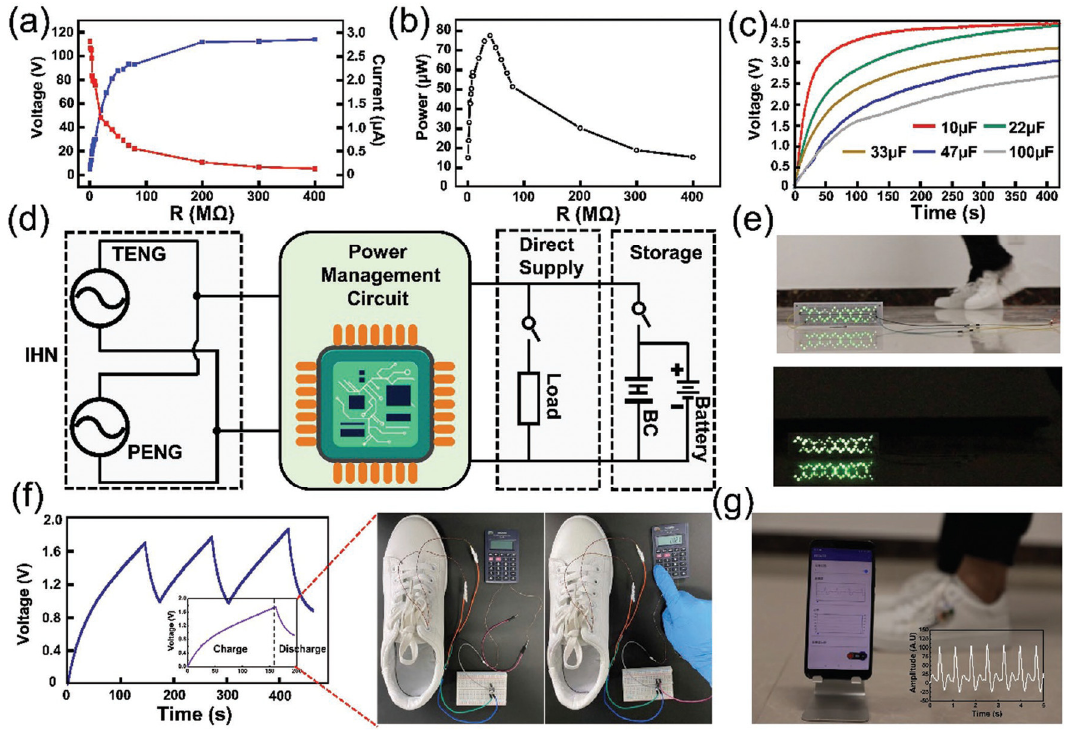
Figure 14. Electrical output performance and applications of IHN proposed by Du et al. [109]. ( a ) Output voltage and current as a function of external load resistance. ( b ) Output power as a function of external load resistance. ( c ) Charge response of four capacitors powered by IHN. ( d ) Schematic view of the electrical circuit for the IHN direct power supply and energy storage system. ( e ) LEDs lighted using the IHN. ( f ) Output voltage and calculator powered by IHN. ( g ) Pulse signal of the dorsalis pedis monitoring system, which was sent to a mobile phone. Reprinted with permission from [109]. Copyright 2020, WILEY-VCH Verlag GmbH & Co. KGaA, Weinheim.